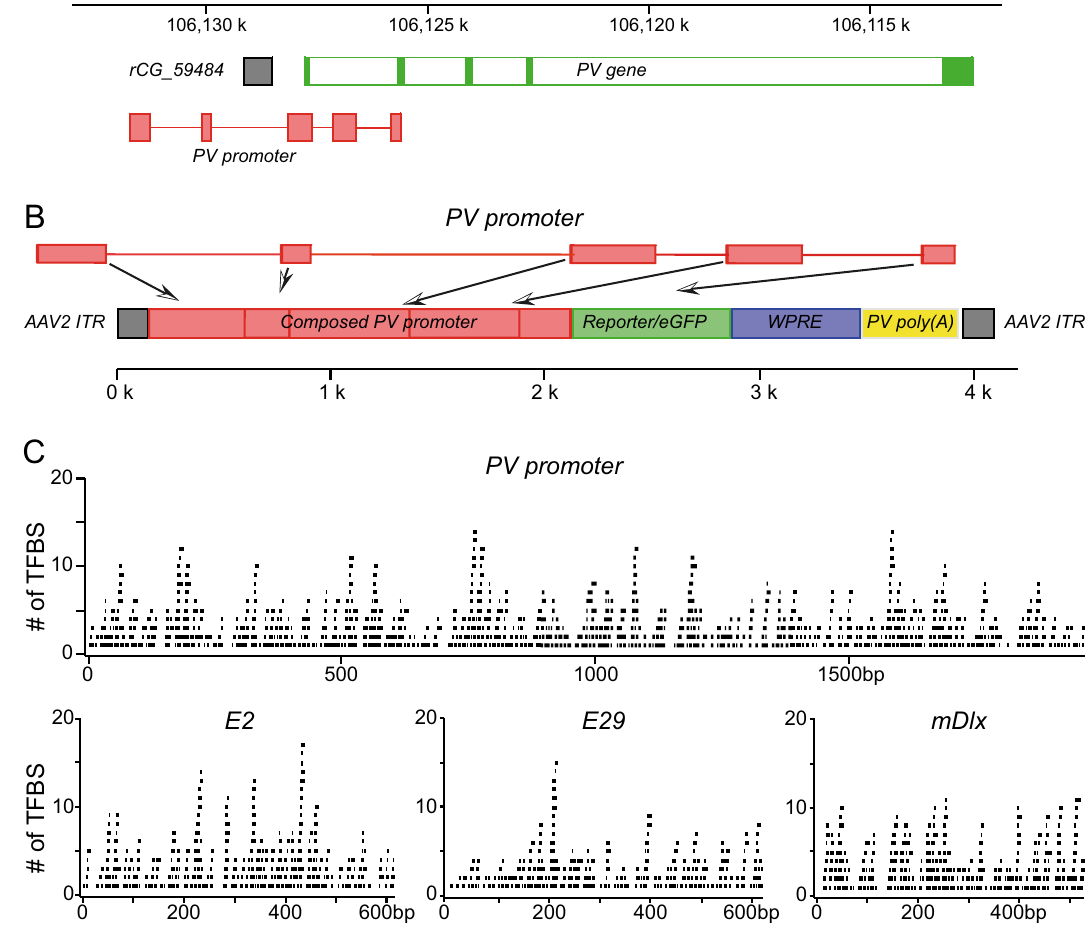
Figure 1. Schematic representation of the promoter design. ( A ) A section of Rattus norvegicus chromosome 7 whole genome shotgun sequence (CM000237.2) is shown that includes PV gene (green filled bars represent exons while open bars represent introns) and a ~ 10 kb upstream sequence. Boxes in light red indicate sequence regions used for the promoter construction. ( B ) The rAAV2 construct used in this study. The actual length of the PV promoter shown above is slightly out of scale. WPRE stands for the Woodchuck Hepatitis Virus Posttranscriptional Regulatory Element and ITR for the inverted terminal repeat. ( C ) Transcription factor binding site (TFBS) analysis for PV promoter and three enhancers that were used for selective expression of proteins in cortical interneurons. Each panel shows the promoter or an enhancer sequence with black bars above indicating the predicted TFBS, a single bar corresponds to one TFBS. For details see